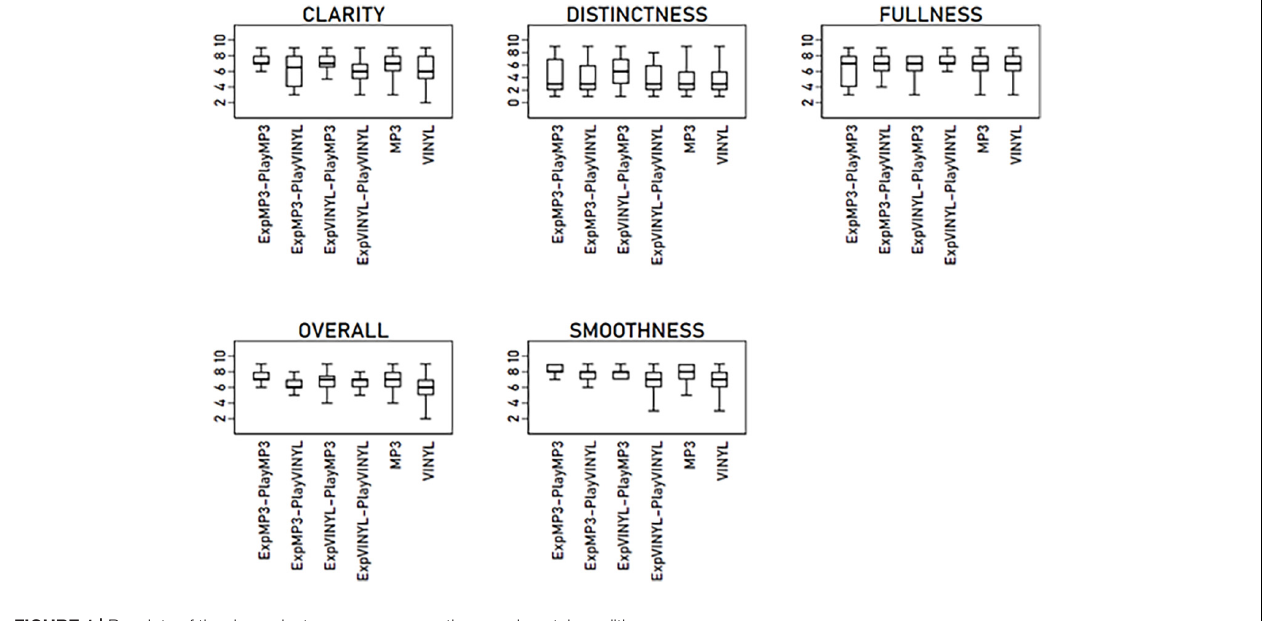
FIGURE 1 | Boxplots of the dependent measures across the experimental conditions.